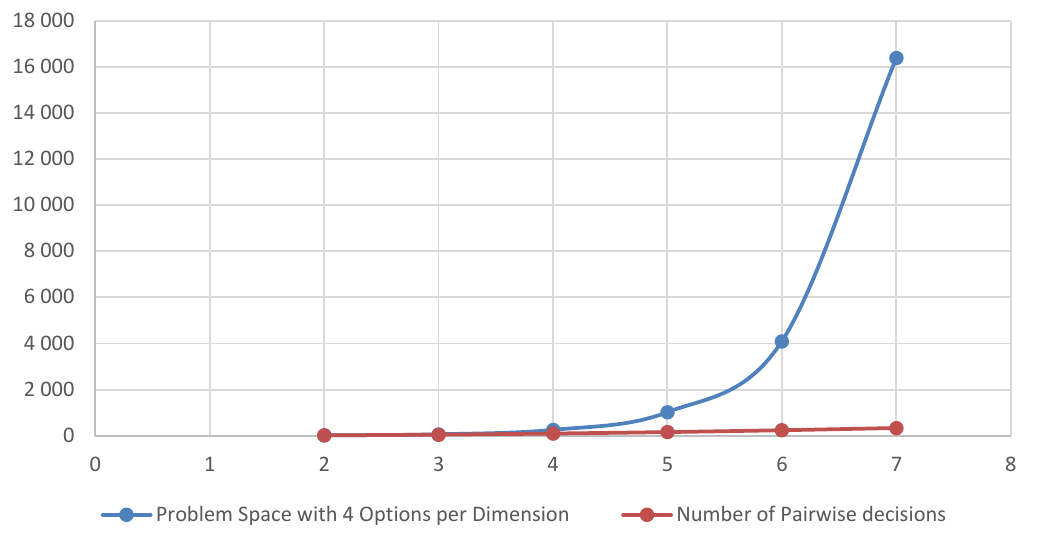
maintain an audit trail Figure 4: Divergence between the increase in the total number of configurations in the problem space versus the total number of pairwise cells that need to be assessed in the Cross- Consistency Assessment